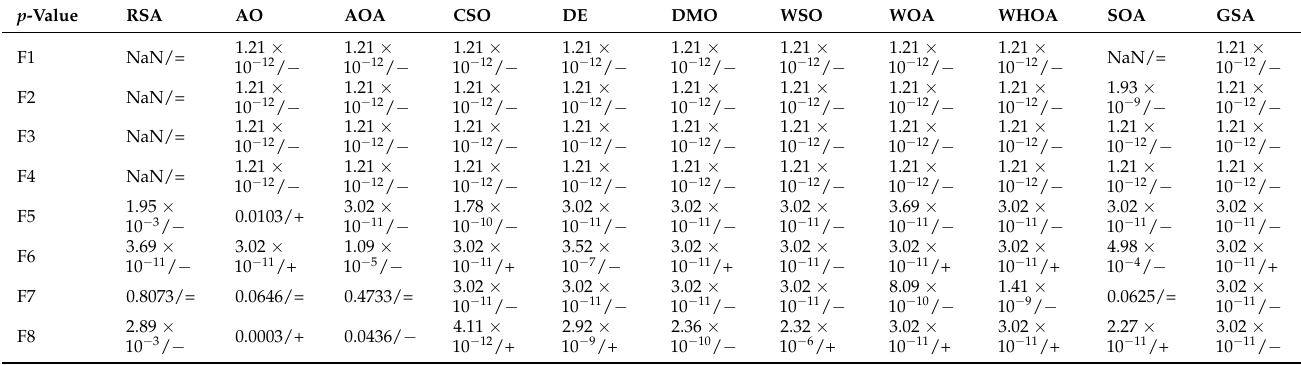
Table 3. p -value and statistical